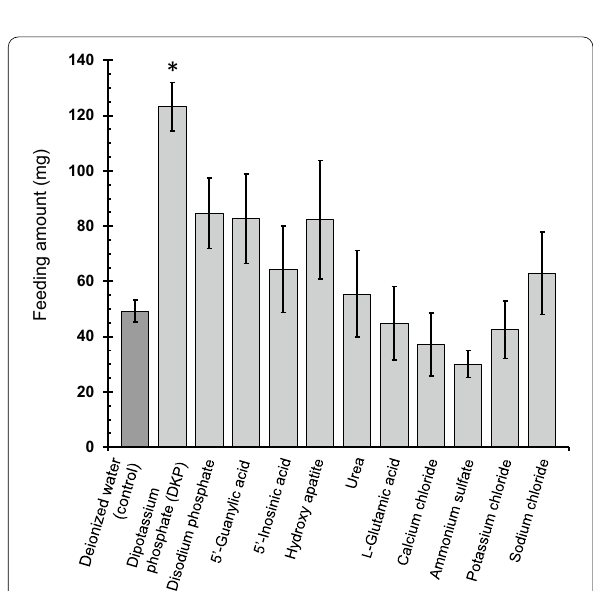
Fig. 3 Total feeding amount (with standard error) of filter paper treated with 11 nutrients or deionized water (control) by Coptotermes formosanus Shiraki under a multiple-choice feeding test. The column with an asterisk is significantly different ( p < 0.01) from the control using Holm mean separation